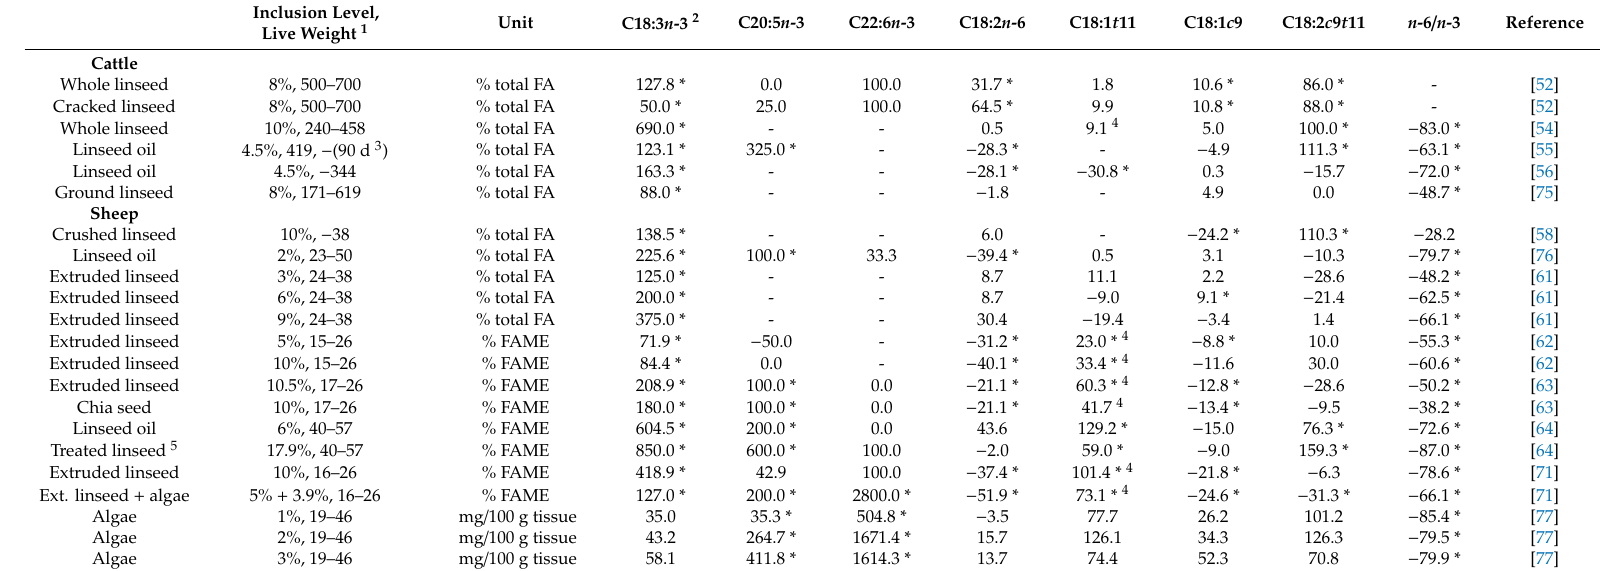
Table 2. Results of di ff erent studies of the e ff ect of dietary inclusion of n -3 long chain polyunsaturated fatty acid (PUFA)-rich sources on the fatty acid composition of subcutaneous fat in ruminants. E ff ects are shown as relative variation with respect to the control diet and expressed in